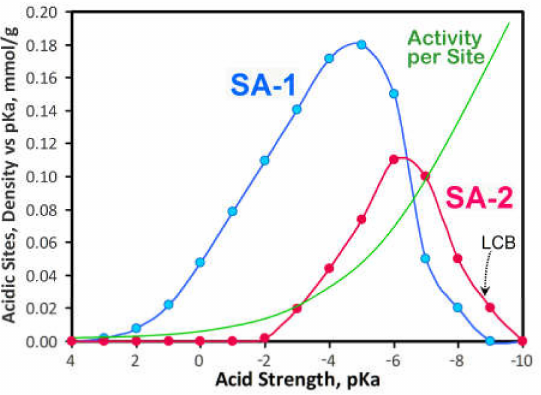
Figure 5. Hammet titrations of two solid acids: SA-1 (sulfated alumina) and SA-2 (fluorided